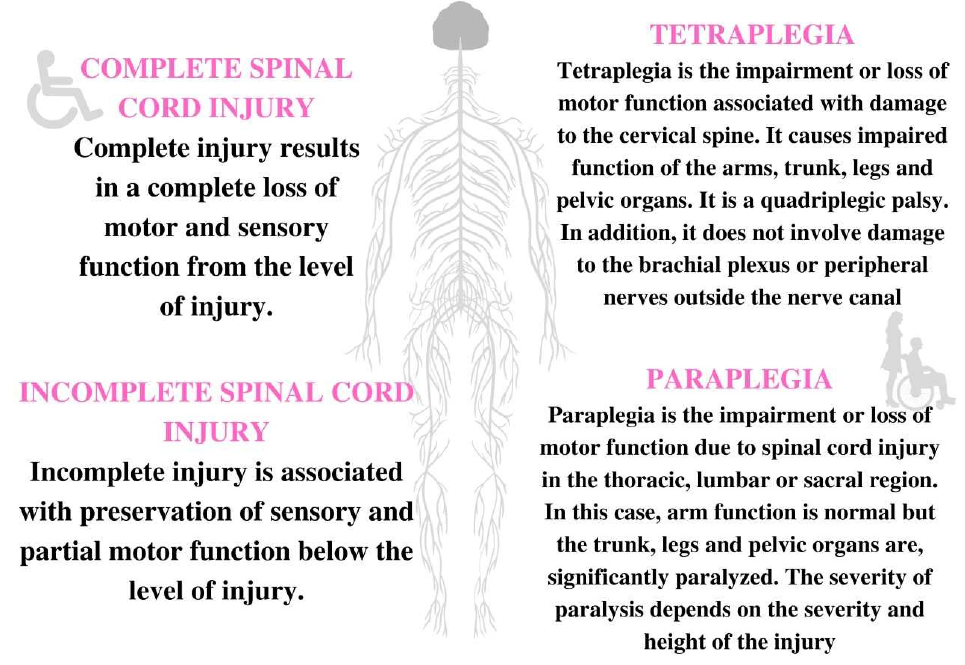
Figure 2. Degrees of